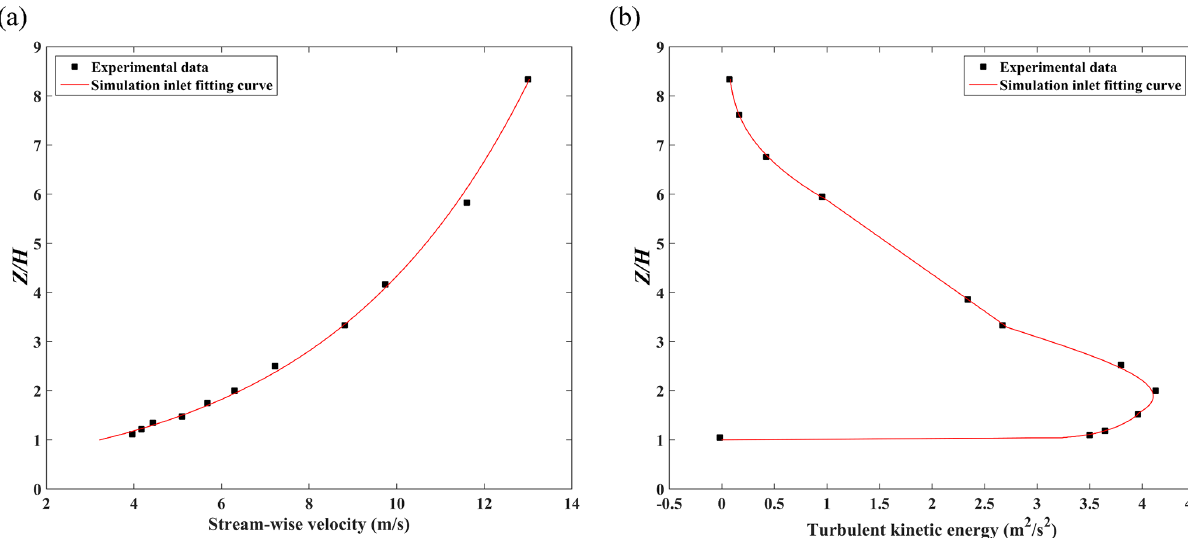
Figure 5. The inlet profile of (a) stream-wise velocity and (b) turbulent kinetic energy in a single street canyon case.